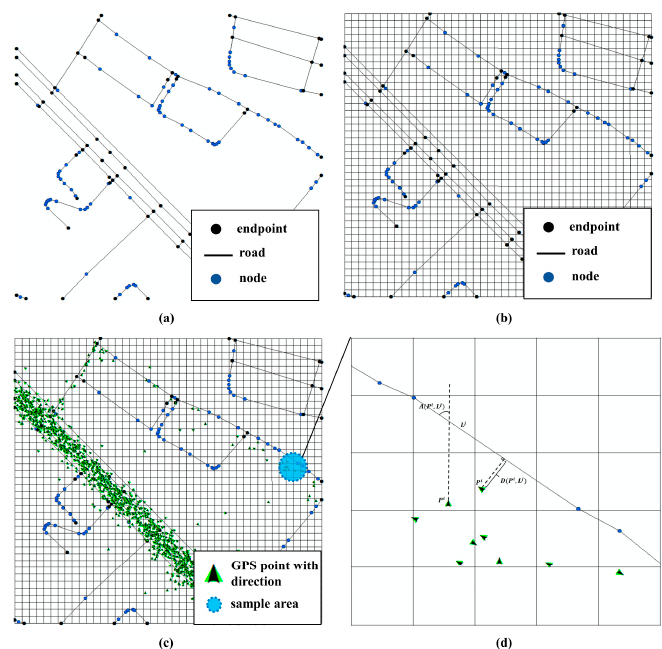
Figure 5. Overview of the process to create a spatial index and a map match. ( a ) Add endpoint at each node to split the polyline to a single line. ( b ) Construct a grid spatial index for the single line dataset to improve the efficiency of the process. ( c ) The distribution of GPS points with directions in the sample area. ( d ) The presentation of method D(𝑃, 𝐿),A(𝑃, 𝐿) to calculate the distance and angle between the directed point and the single line.